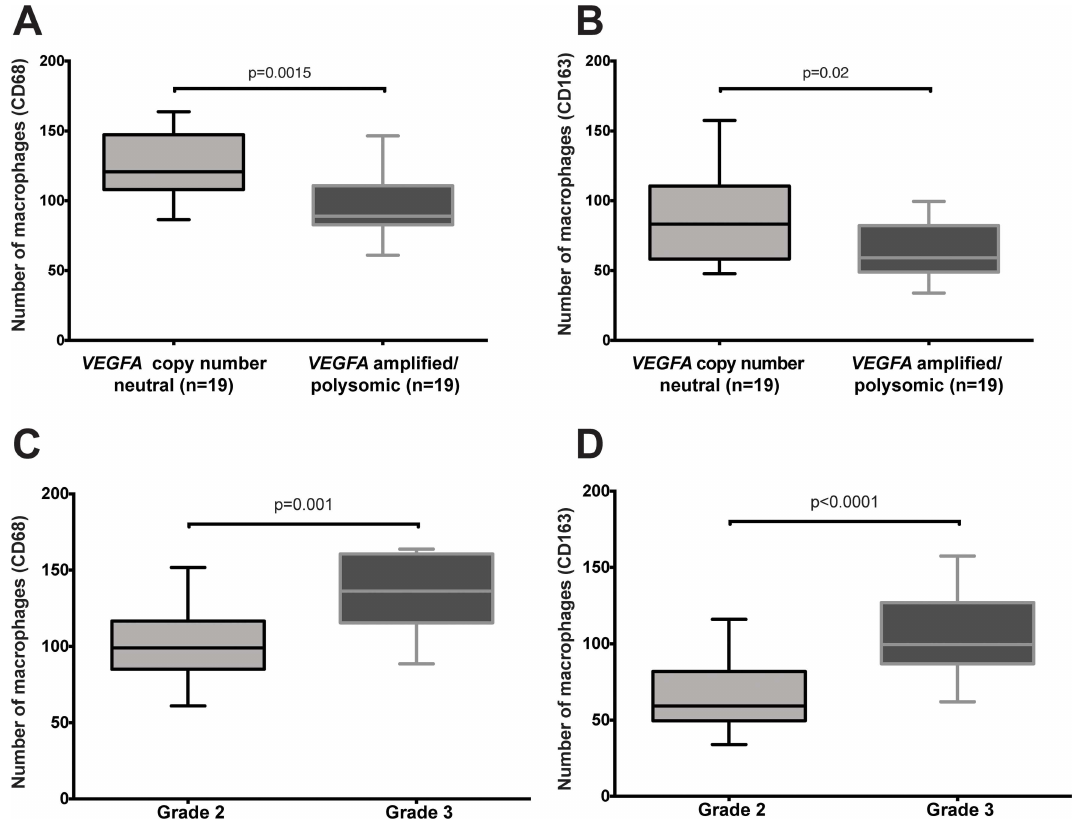
Fig 3. Number of macrophages in colorectal cancers,using CD68 and CD163markers. Boxplots depict the number of (A, C) CD68+ and (B, D) CD163+cells (A, B) in CRCs with and without VEGFA amplification/polysomyand (C, D) in CRCs of intermediateand high